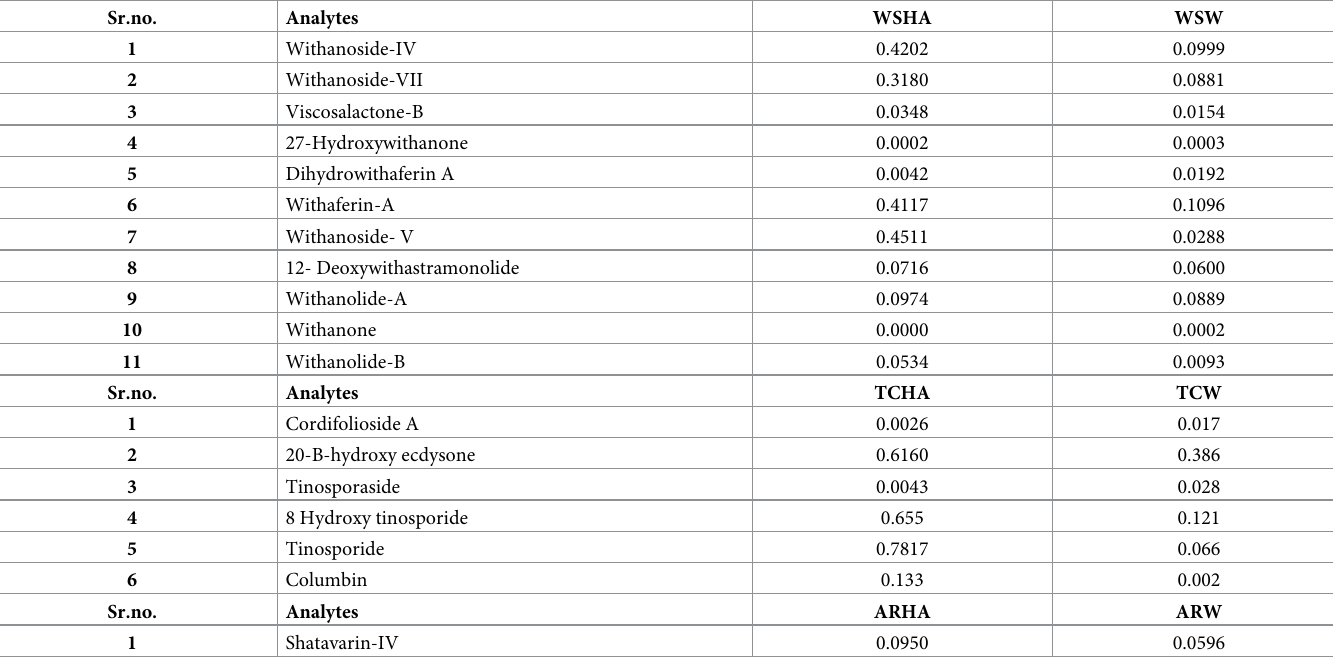
Table 1. Quantification ( n = 3) results (%) in WS, TC and AR hydroalcoholic and water extract.